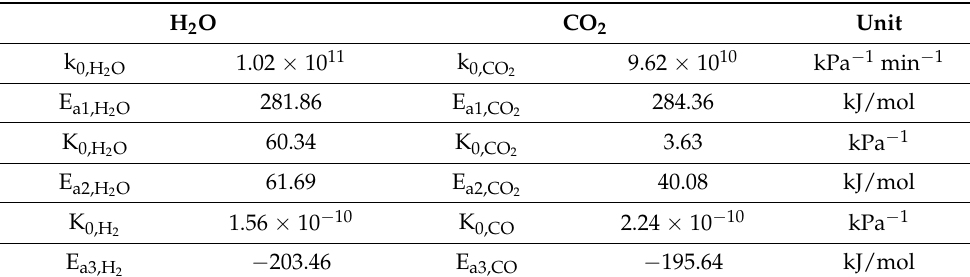
Table 3. Kinetic parameters for char gasification obtained from experimental